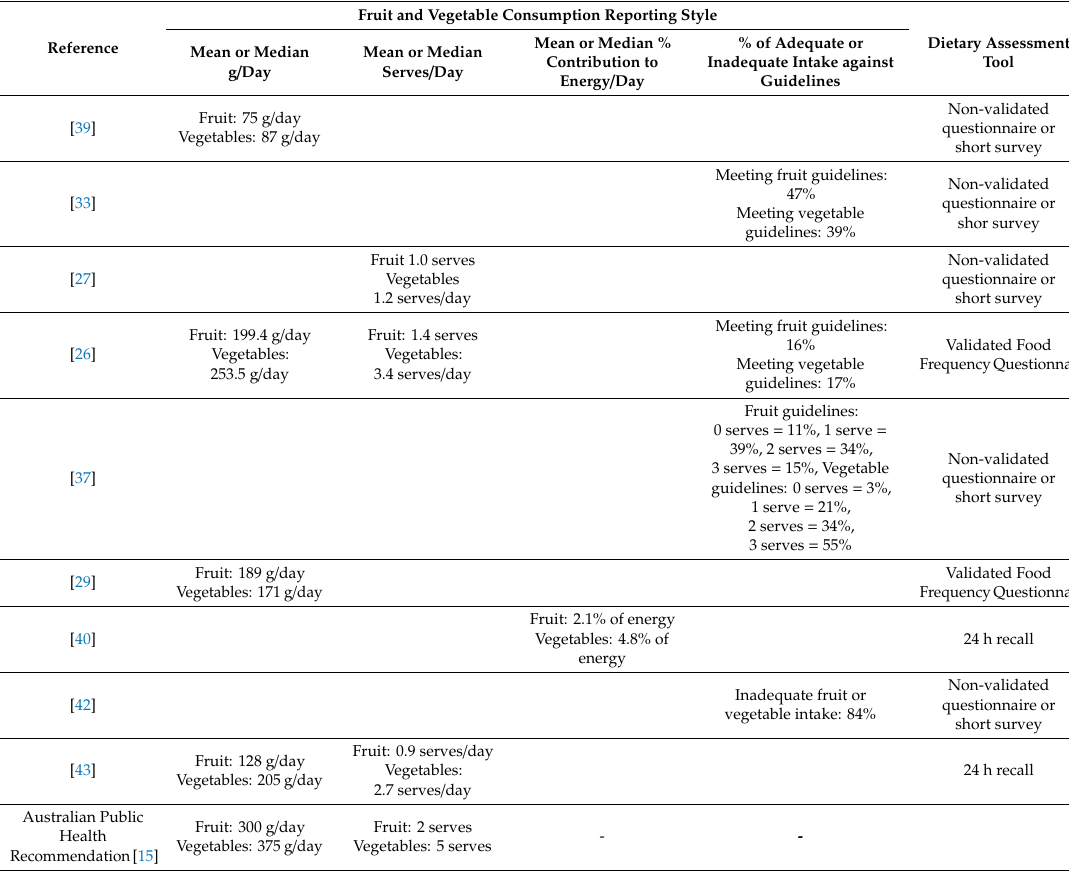
Table 3. Comparison of outcomes for fruit and vegetable intake and the dietary assessment tool used among the included